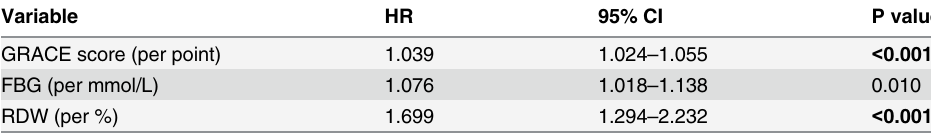
Table 4. Multivariate Cox analysis for major adverse cardiovascular